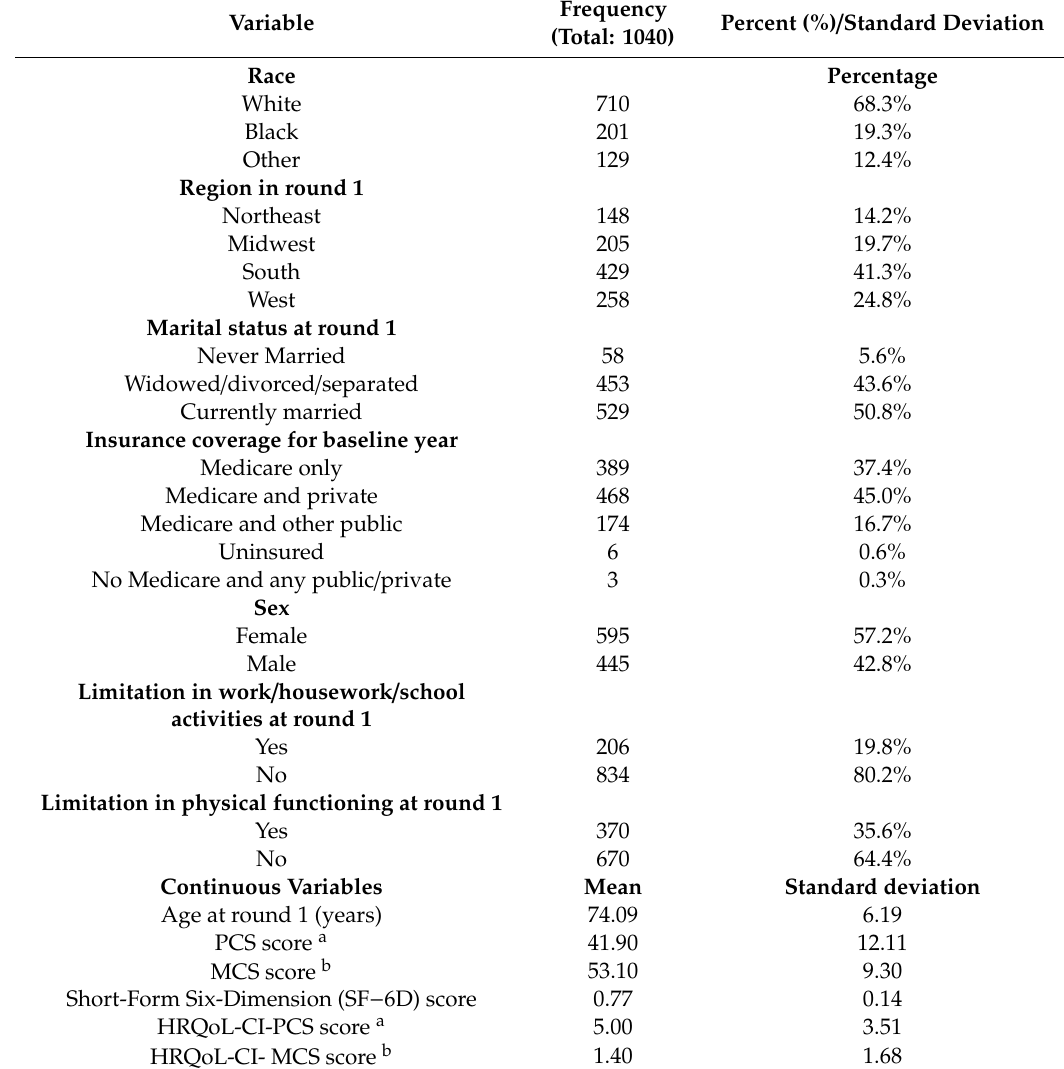
Table 1. Demographic characteristics of sample at